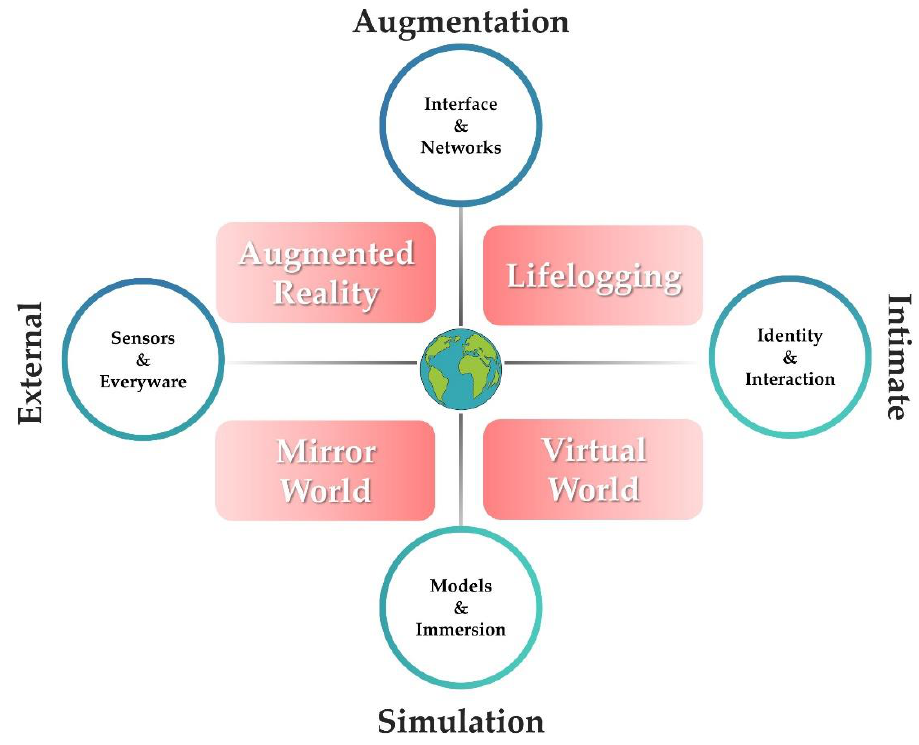
Figure 1. Four Types of